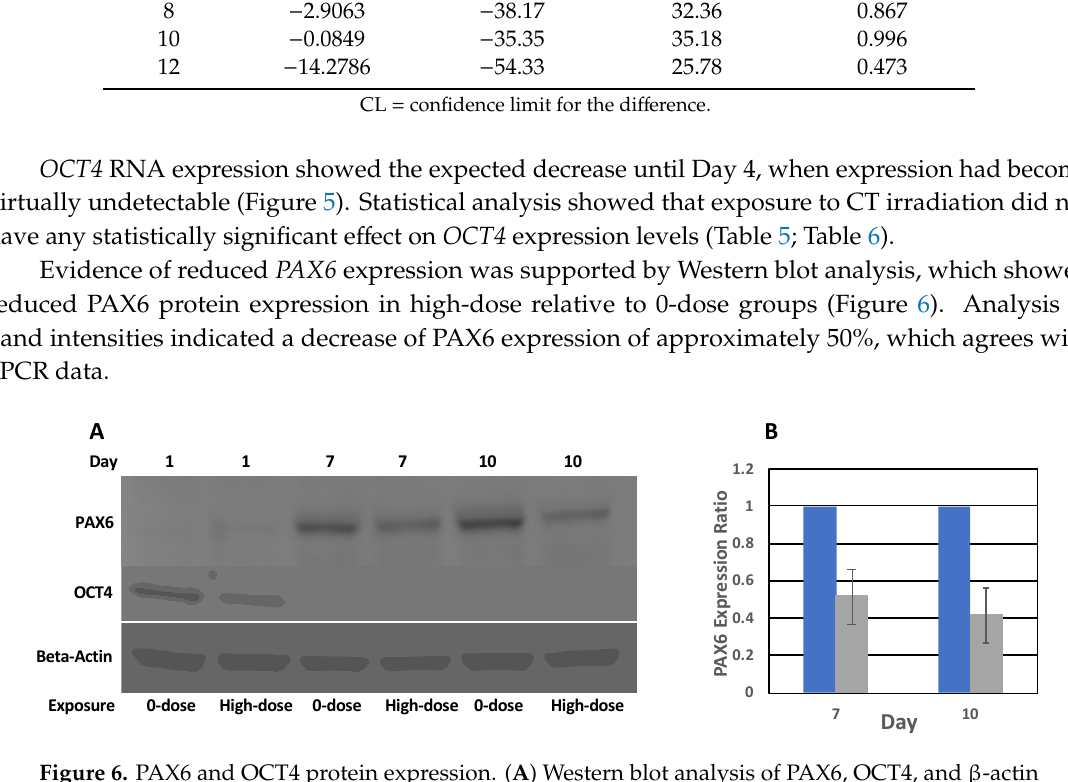
Figure 6. PAX6 and OCT4 protein expression. ( A ) Western blot analysis of PAX6, OCT4, and β-actin protein expression in 0-dose and high-dose samples. Images of the same membrane probed by different antibodies are presented. ( B ) Quantitation of Western blot data of PAX6 expression on Days 7 and 10 in high-dose (grey) samples relative to 0-dose (blue) samples. Error bars show standard deviations of three Western blot experiments.